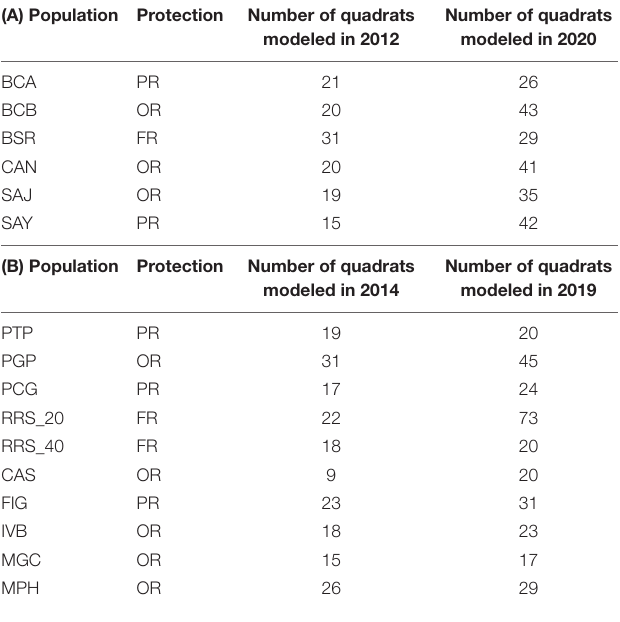
TABLE 1 | Number of quadrats modeled for each site in Cerbère-Banyuls reserve (A) and Calanques National Park (B) in each protection status (FR, Full Reserve; PR, Partial Reserve; OR, Outside